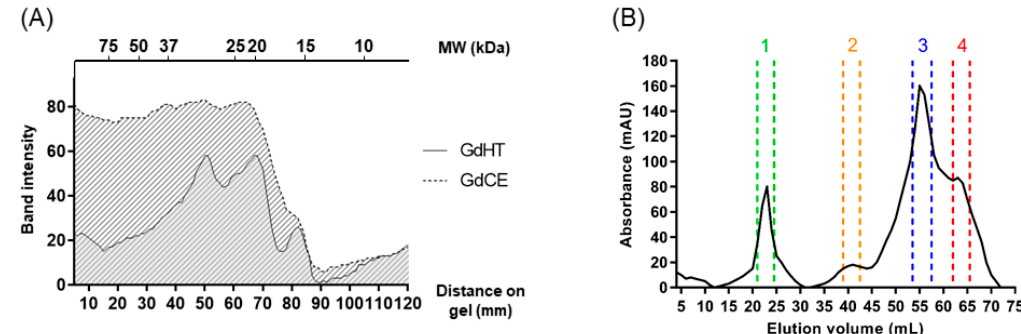
Figure 1 . Isolation and purification of antioxidant peptides from Geoffroea decorticans seeds. ( A ) Densitogram of SDS-tricine-PAGE of the crude extract of Geoffroea decorticans (GdCE, dotted line) and the heat-treated sample (GdHT, solid line). ( B ) Size-exclusion chromatography elution profile of the Geoffroea decorticans heat-treated sample. Fractions 1–4 selected for posterior analysis are shown between dotted lines.